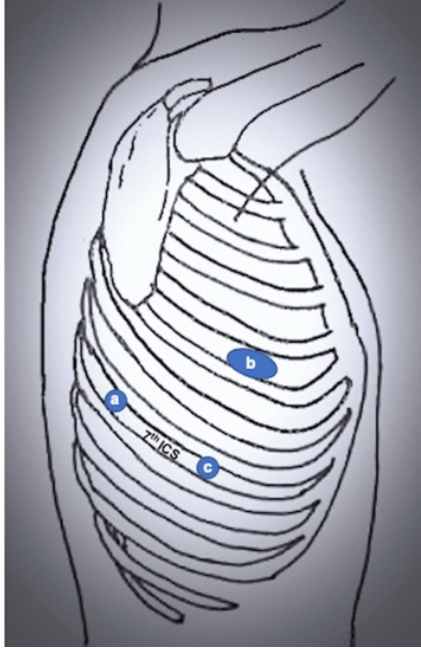
Figure 2. Port mapping of 3-port RATS. ( a ) robotic left arm; ( b ) utility incision; ( c ) camera port.